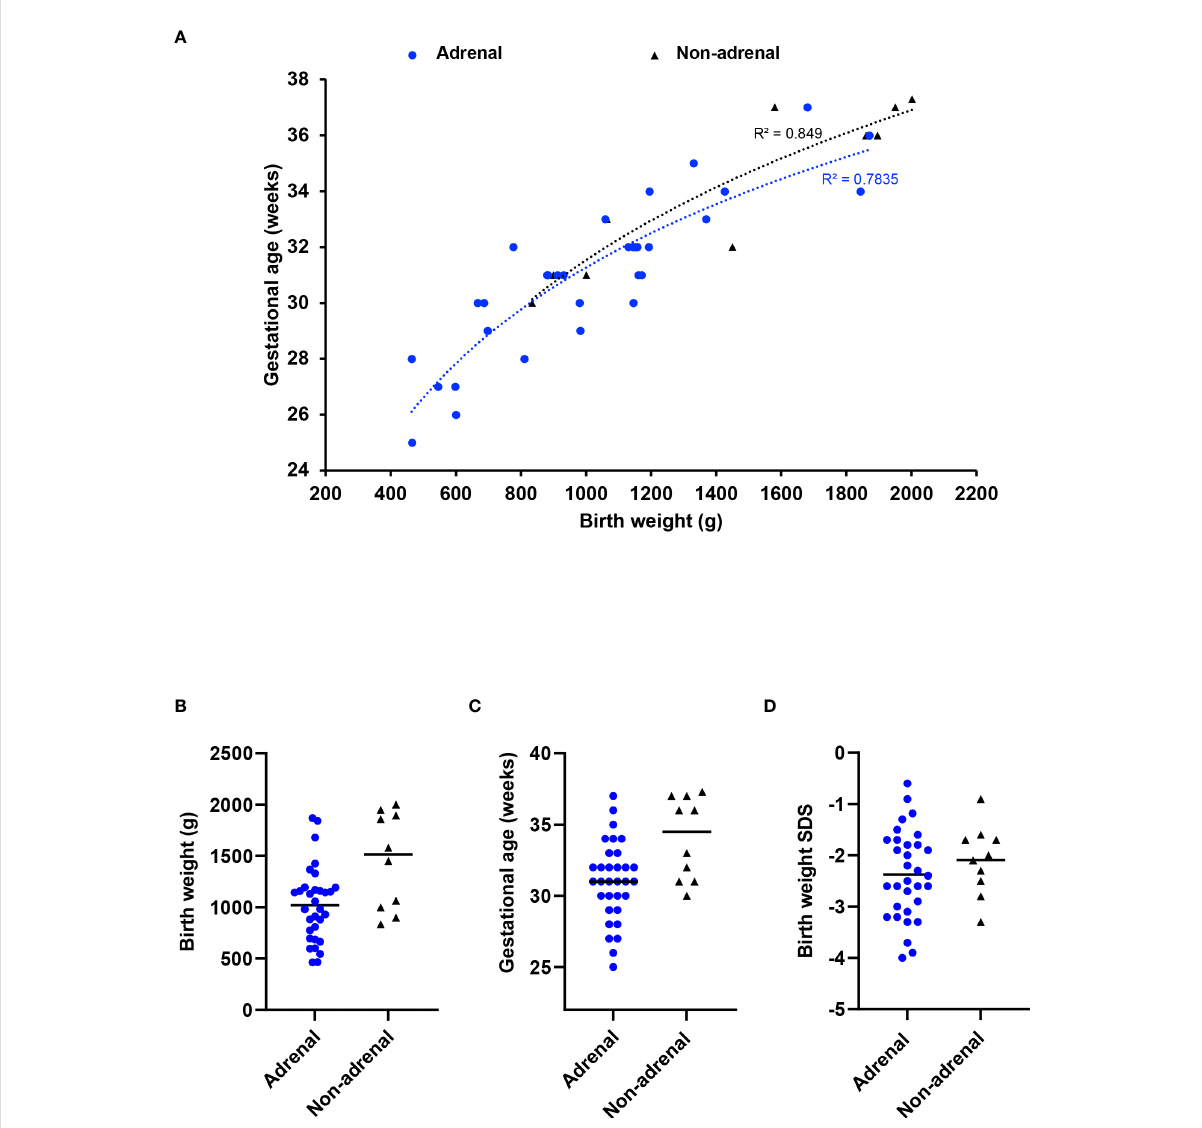
FIGURE 2 Relation between adrenal insuf fi ciency and gestational age/birth weight. (A) Correlation plot between gestational age and birth weight at delivery for children with MIRAGE syndrome, with or without adrenal insuf fi ciency. A logarithmic trendline and an R squared value for each phenotypic group is shown. Birth weight (B) , gestational age in weeks (C) and birth weight standard deviation score (SDS) (D) of children with MIRAGE syndrome reported to date, with and without adrenal insuf fi ciency, with median values shown by the horizontal